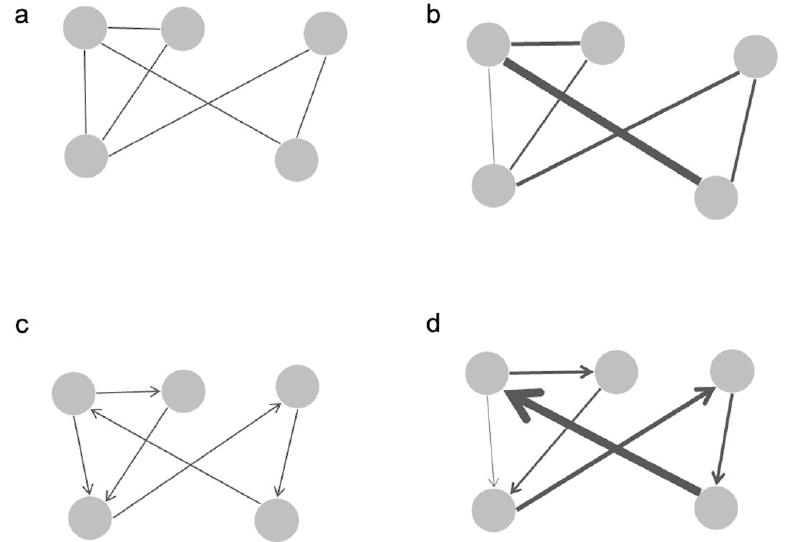
Figure 1. The circles represent network nodes, and the lines connecting the nodes are termed as edges. The edges of a network can be binary ( a ) or weighted ( b ). Thick bolded and highlighted lines represent weighted edges. Binary graphs may be useful when studying the topology of the network, while weighted graphs represent the diversity of connections between neural elements in the brain. Undirected straight-line connectors represent undirected edges, while the arrows represent directed edges. Edges may also be undirected ( a , b ) or directed ( c , d ) depending on the method used to construct the graph. In vivo human studies utilize undirected graphs. Note that these planar graphs are for visualization only, and real brain graphs do not necessarily have to be planar. Figure adapted from Farahani et al. 2019 [7] .